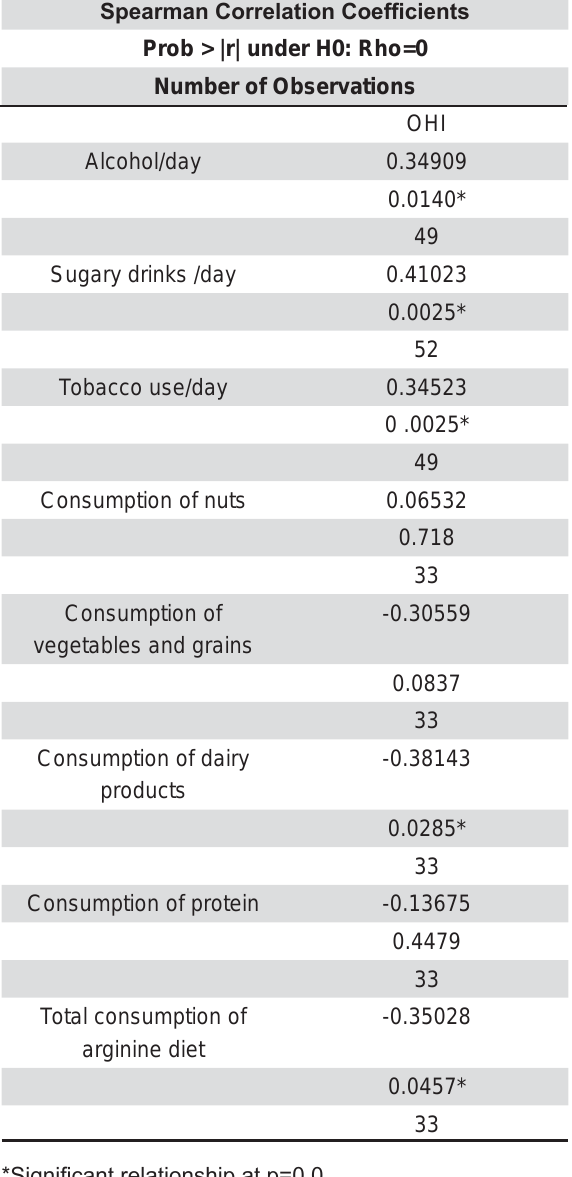
Table 5- (cid:3)(cid:39)(cid:76)(cid:86)(cid:87)(cid:85)(cid:76)(cid:69)(cid:88)(cid:87)(cid:76)(cid:82)(cid:81)(cid:3)(cid:82)(cid:73)(cid:3)(cid:70)(cid:82)(cid:85)(cid:85)(cid:72)(cid:79)(cid:68)(cid:87)(cid:76)(cid:82)(cid:81)(cid:3)(cid:70)(cid:82)(cid:72)(cid:73)(cid:191)(cid:70)(cid:76)(cid:72)(cid:81)(cid:87)(cid:86)(cid:3)(cid:73)(cid:82)(cid:85)(cid:3)(cid:83)(cid:68)(cid:87)(cid:76)(cid:72)(cid:81)(cid:87)(cid:182)(cid:86)(cid:3) characteristics and oral hygiene